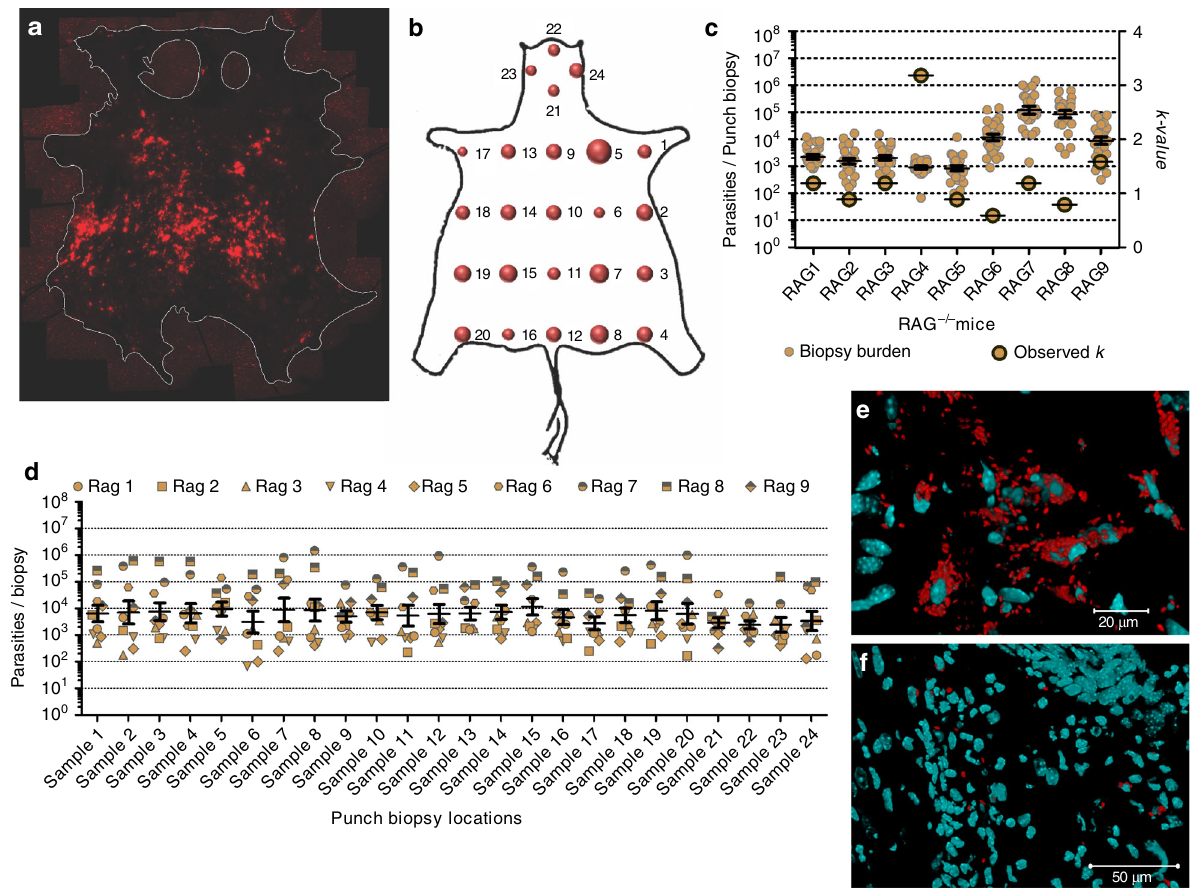
Fig. 1 Analyzing skin parasite load and distribution. a Composite image of tdTom-expressing L. donovani parasites ( red ) in the skin of a representative infected RAG mouse (RAG9), imaged from the hypodermal face by fl uorescent stereomicroscopy (see Supplementary Fig. 1 for more details). Skin edges were marked for better contrast. b Bubble plot of accumulative biopsy data for all RAG mice (biological replicates N = 9; see Supplementary Fig. 2 for more details). c Scatter plot of parasite loads per skin biopsy for each mouse (ø 0.8 cm; vol. 12 mm 3 ; technical repeats N = 24 per mouse; left y-axis ) and observed k -value for parasite distribution for each mouse ( right y-axis ). Mean and standard errors are shown for parasite load data. Skin-biopsy parasite load variability per mouse were analyzed by two-tailed one-sample t -test ( P < 0.001 each), data variance between all mice (biological replicates N = 9) within the group by Brown-Forsythe test ( P < 0.001) and mean biopsy parasite load by one-way Kruskal-Wallis test ( P < 0.001). d Scatter plot for parasite density per biopsy location for all 24 biopsy locations across all mice (biological replicates N = 9 per biopsy site, total N = 216) analyzed by one-way Kruskal-Wallis test ( P = 0.996). Mean and standard error bars are shown. e , f Magni fi ed z-stack tile-scan images of skin areas containing heavily e and sparsely f parasitized mononuclear cells (full image in Supplementary Figs. 4, 5, respectively). Scale bars: 20 µ m in e , 50 µ m in